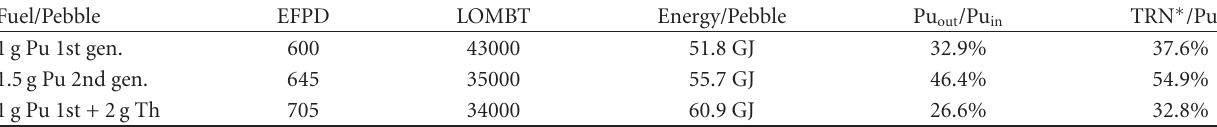
Table 1: Summary of obtained results ( k ∞ ∼ 1 . 05) [4].